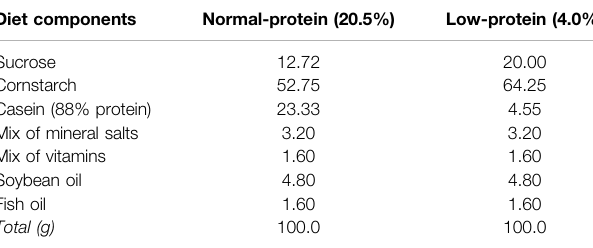
TABLE 1 | Composition of the isocaloric low- and normal-protein diets. Diet